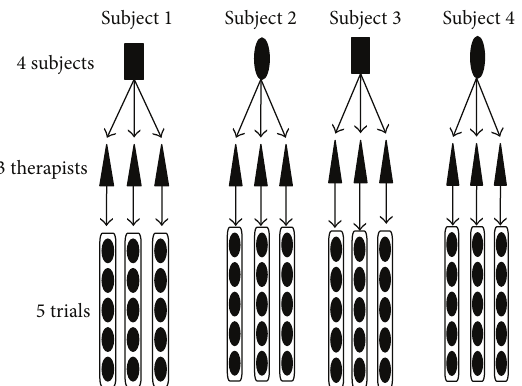
Figure1:Studydesignandmeasurementprocedure.Afterfivetrials, the infrared reflective markers were removed, and another tester then attached the infrared reflective markers to the same